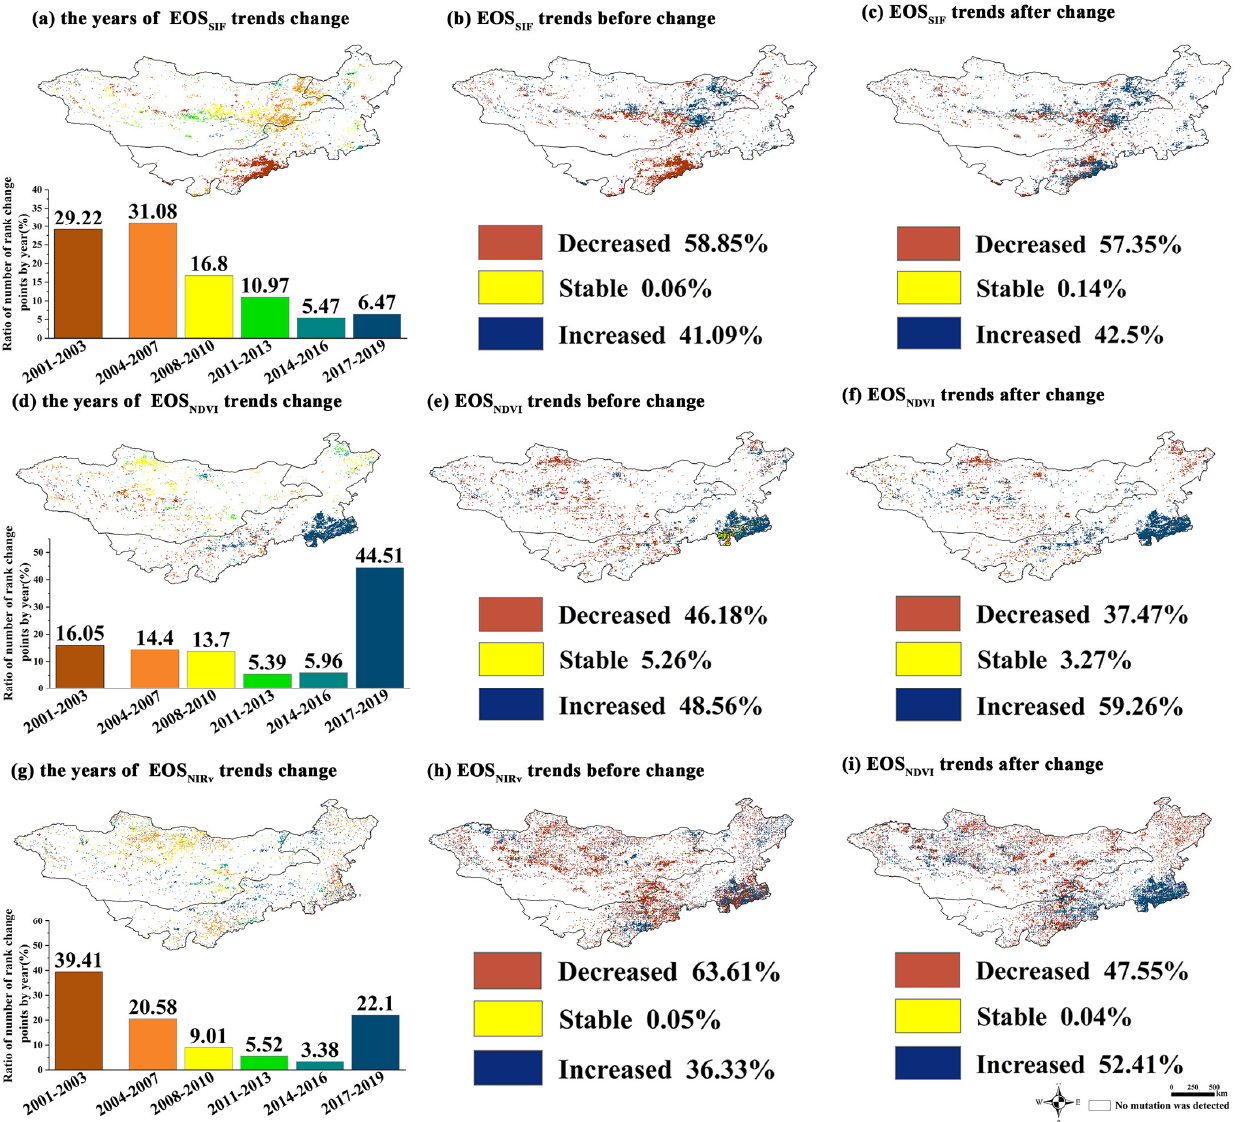
Figure 7. The years of the EOS change-trends in the past 20 years and a trend comparison before and after the change: ( a , d , g ) are the years of the change-points and the change proportions of EOS SIF , EOS NDVI and EOS NIRv, respectively; ( b , c ), ( e , f ) and ( h , i ) are the trends before and after the changes of EOS SIF , EOS NDVI and EOS NIRv , respectively.